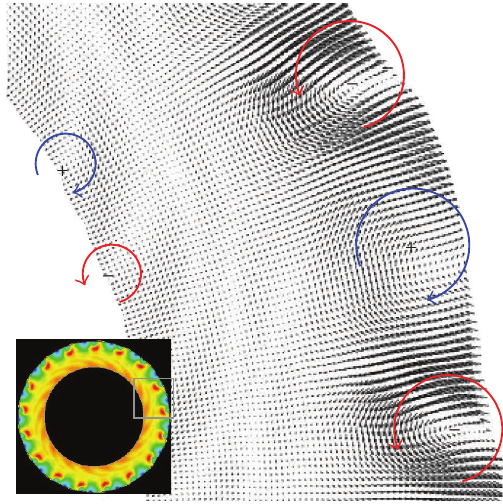
Figure 4: Relative velocity flow field corresponding to a two- dimensional rotating